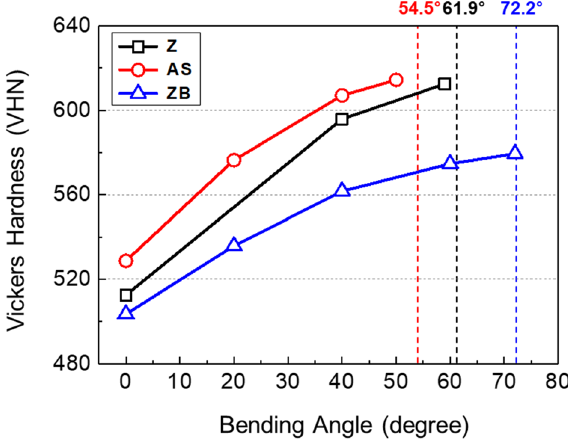
Figure 10. Vickers hardness of the coating/steel interfacial area as a function of bending angle for the Z, AS, and ZB steels. The hardness increases almost linearly with increasing bending angle in the three